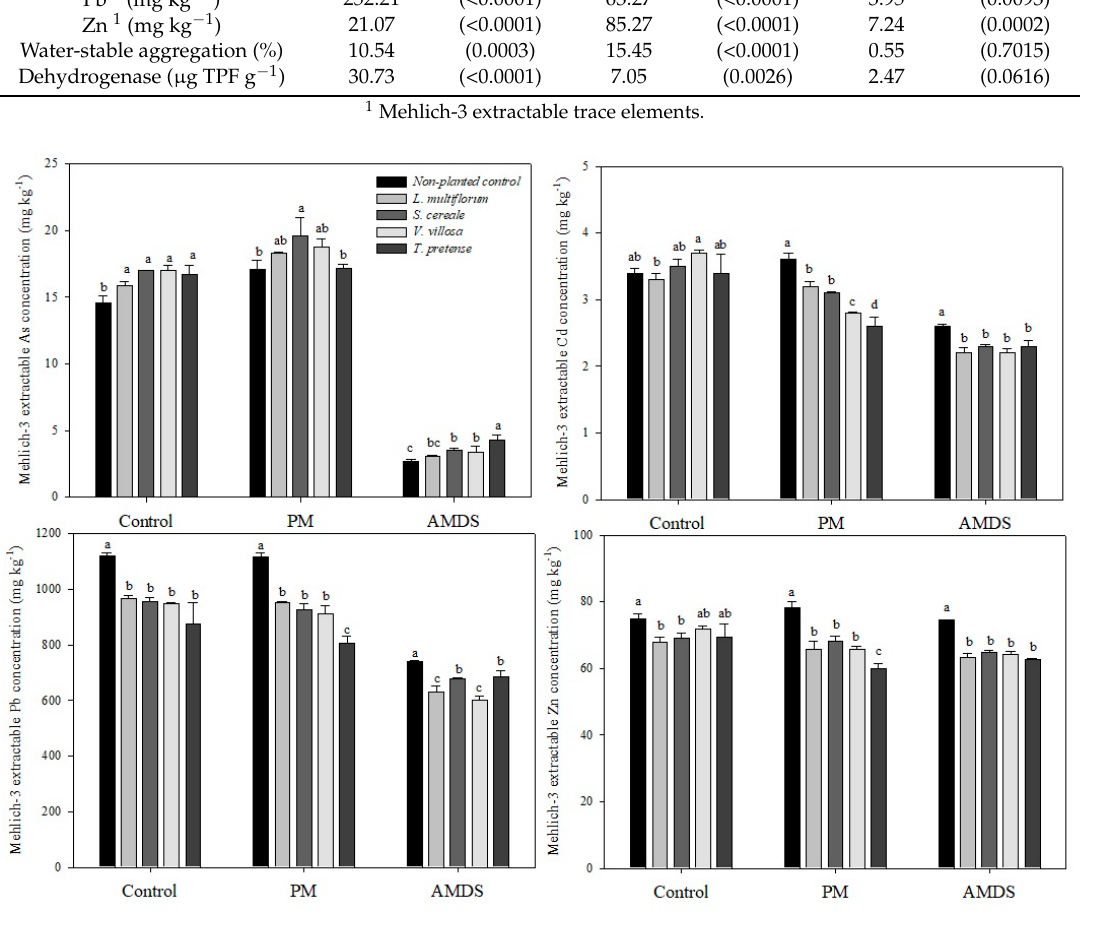
Figure 2. Mehlich-3 solution extractable trace elements concentrations with different types of cultivated plants ( Loliummultiflorum and Secalecereale (Poaceae family representatives) and Trifoliumpratense and Viciavillosa (Leguminosaefamily representatives)) and amendment treatments (Control; PM, pig manure; AMDS, acid mine drainage sludge). Different letters indicate significant differences among the NPC (nonplanted control) and the four plant species with same treatment, using Tukey’s test. Error bars represent ± standard deviation of three replicates ( n = 3).